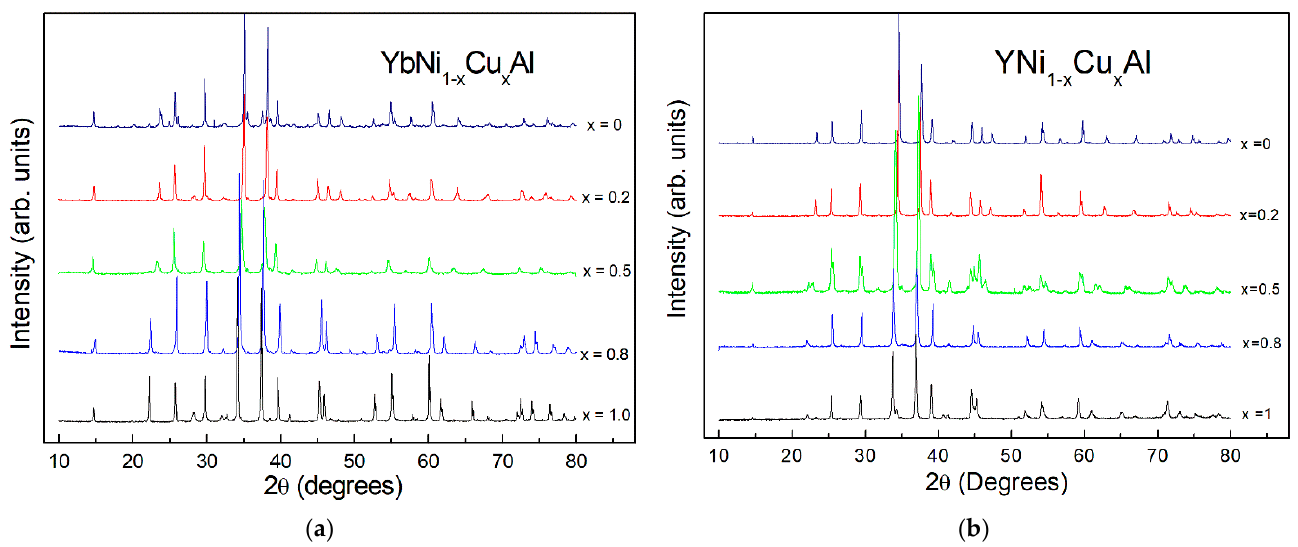
Figure 1. X-ray diffraction patterns of the YbNi 1 - x Cu x Al ( a ) and YNi 1 - x Cu x Al ( b ) series of alloys. All samples crystallize in a hexagonal ZrNiAl-type structure. The patterns of the different samples are shifted for comparison purposes.